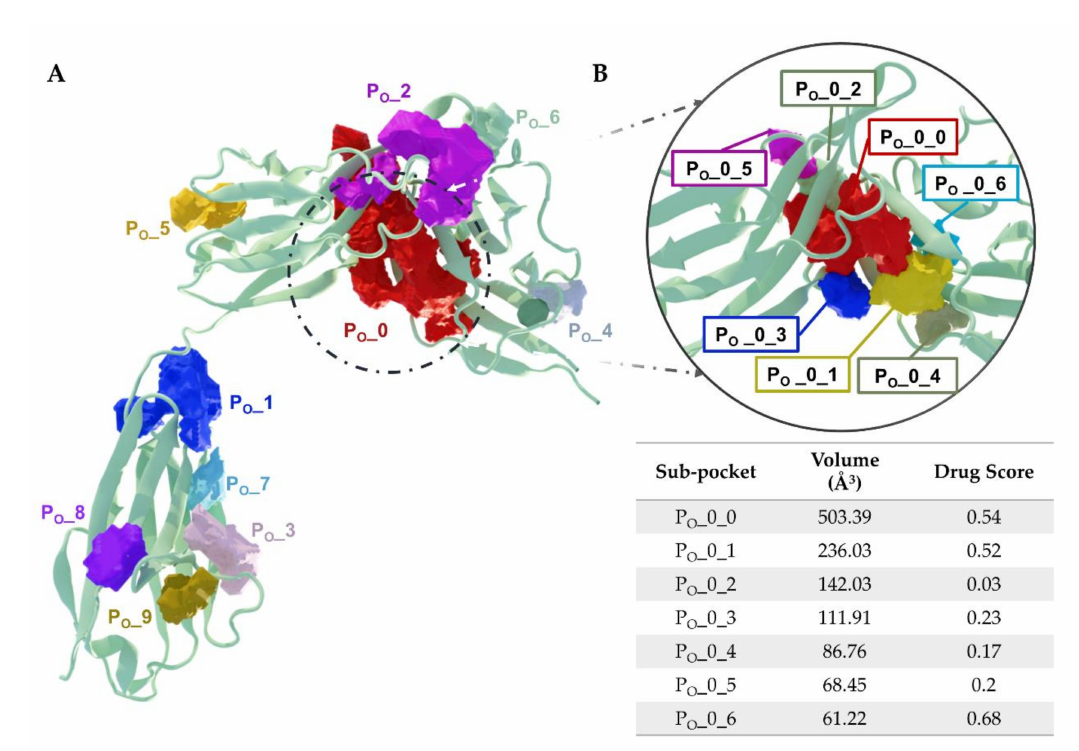
Figure 6. Binding pocket prediction on the IL-1R1 ectodomain surface (PDB entry 4GAF), using the DoGSiteScorer tool. ( A ) Ten binding pockets are shown: P O _0 (red); P O _1 (blue); P O _2